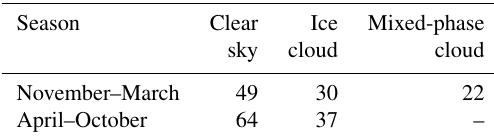
Table 2. Number of spectra used in each TS according to the macro- season. The total number of spectra used in the TS is